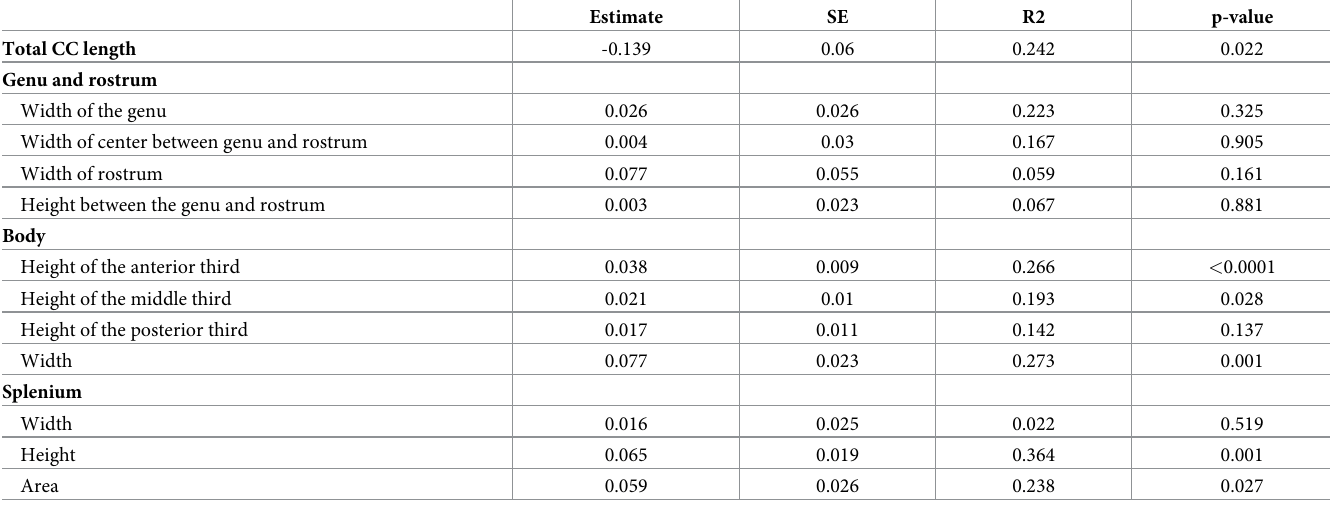
Table 3. Associations between MMSE score and each MRI